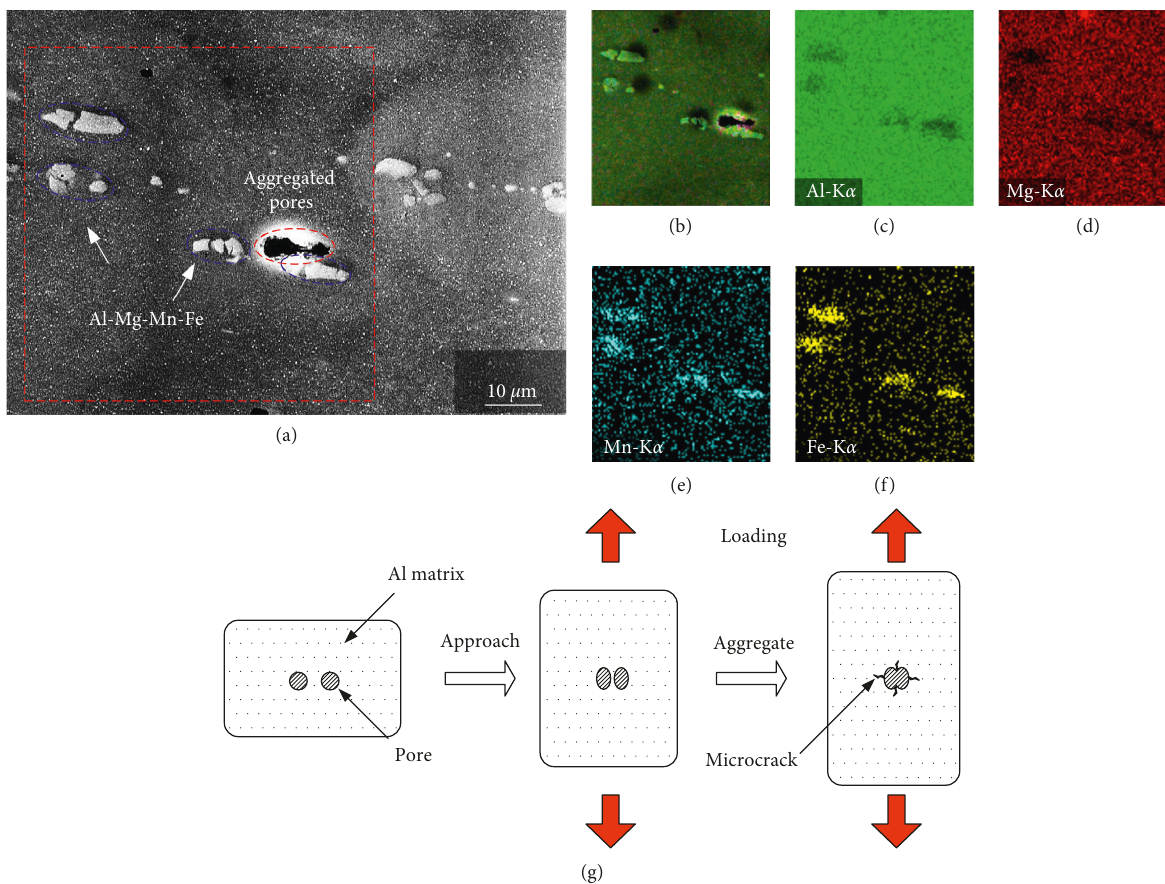
Figure 4: The aggregated pores in the matrix of ϕ 5.2mm wire: (a) SEM micrograph of the aggregated pores; (b) EDX element mappings; (c)–(f) the distribution of Al, Mg, Mn, and Fe, respectively; (g) schematic diagram of the aggregated pores.